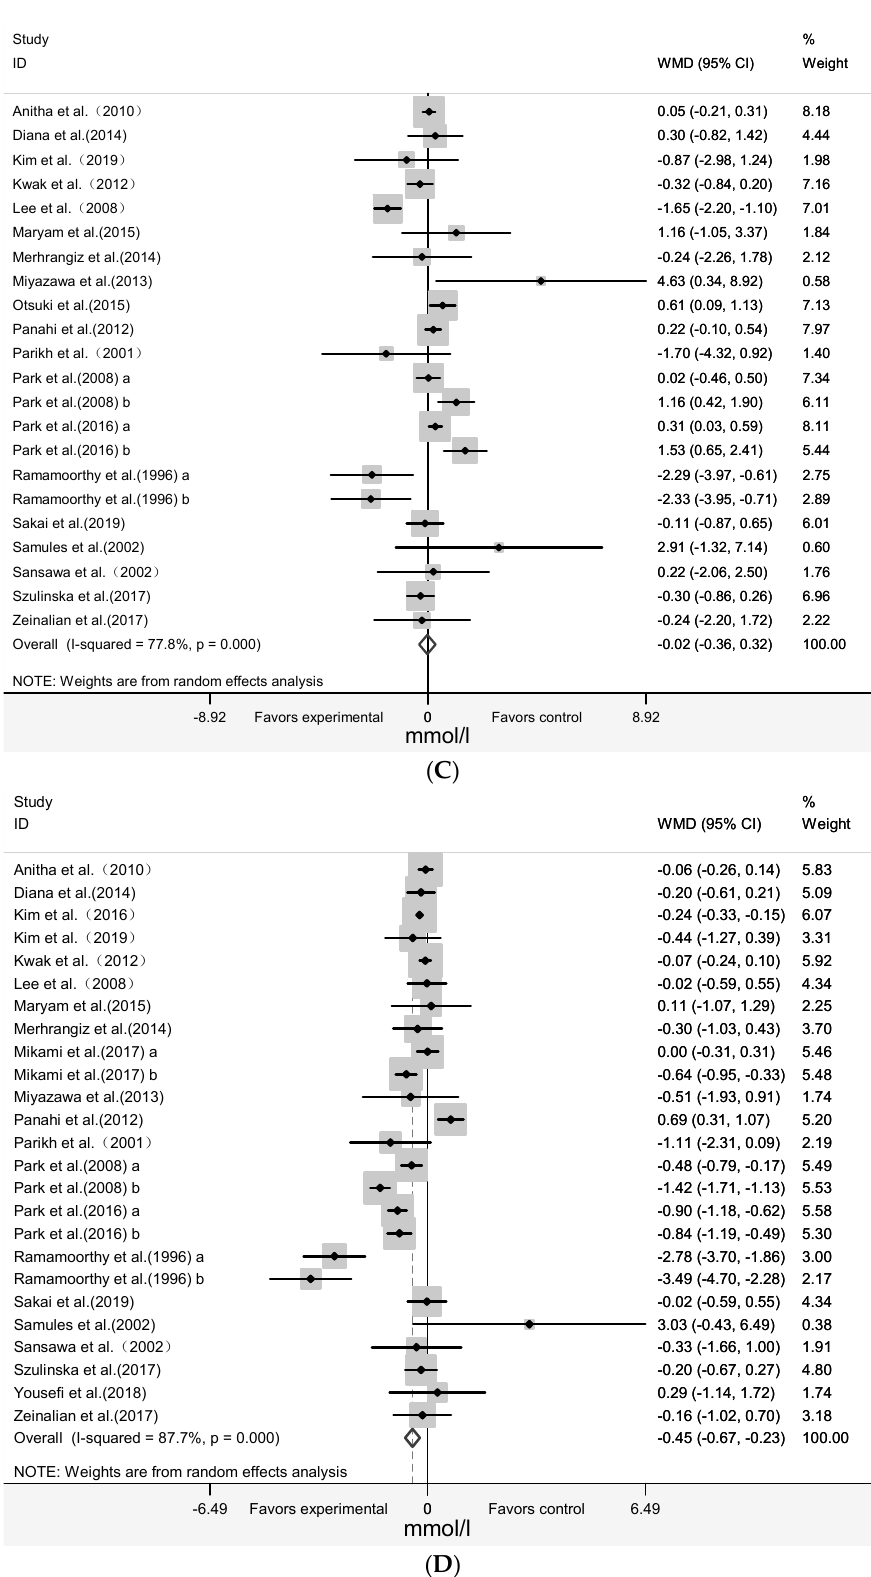
Figure 2. Forest plot of the effect of algae supplementation on high-density lipoprotein cholesterol ( A ), low-density lipoprotein cholesterol ( B ), triglycerides ( C ), and total cholesterol ( D ). 3.3. Effect of Algae and Its Extract Intervention on Fast Plasma Glucose and 2-Hour Postprandial Blood Glucose